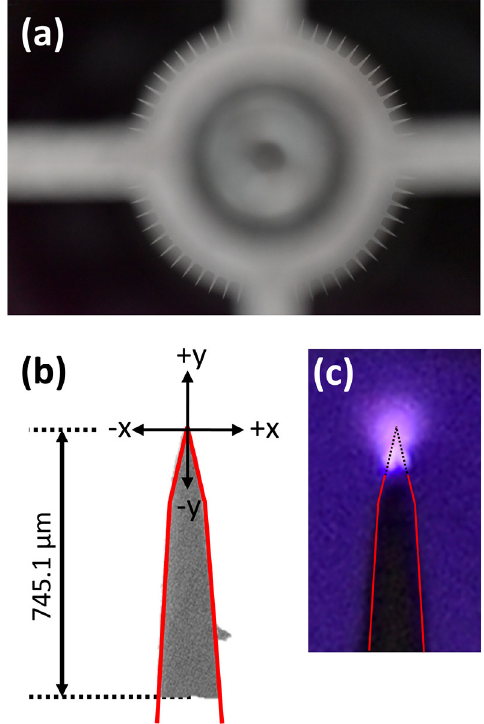
Figure 2. ( a ) Image of the front view showing the round metal in each cylindrical individual unit of PSAPD. The 60 rectangular tips, with the length of ~2 mm, are engineered on the external circumference; ( b ) photograph of a single tip showing the geometry and the scanning direction of the fiber optic head with respect to the tip. The position of the top of the tip is 0, while x refers to the horizontal direction and y refers to the vertical direction; ( c ) photograph of a sustained non-thermal plasma created on the top of the tip. The red line indicates the boundary of the tip, and the dotted line indicates the part of the tip inside the plasma